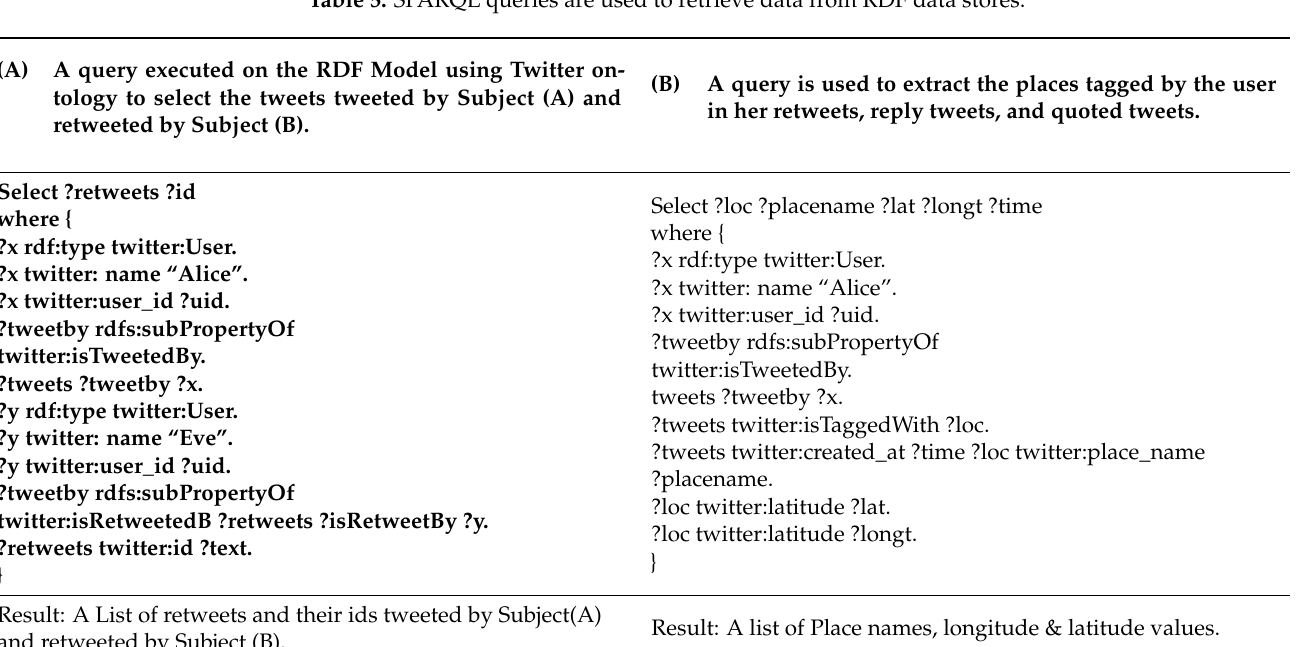
Table 5. SPARQL queries are used to retrieve data from RDF data stores.